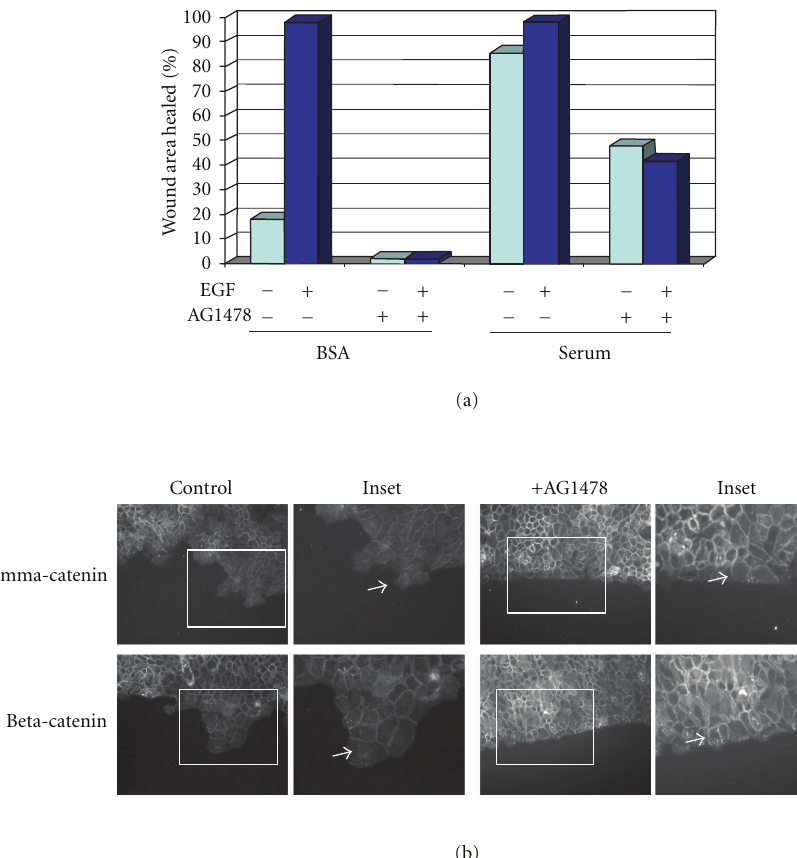
Figure 2: Junctions at the wound margin are retained upon EGF receptor inhibition. Cells were grown to confluence, placed in serum- free medium overnight, and then a wound was introduced with a pipette tip. Cells were washed 3X with PBS, then placed in serum-free medium +/ − 20nM EGF and +/ − 5 μ M of the selective EGF receptor inhibitor AG1478 as indicated for 24 h. (a) The area of wound closure was measured using ImagePro software. (b) After wounding, cells were fixed and immunostained for either gamma-catenin (plakoglobin) or beta-catenin. Note the loss of border staining is limited to the wound edge (see arrows). Upon EGF receptor inhibition, junctional proteins are apparent at the wound edge (see